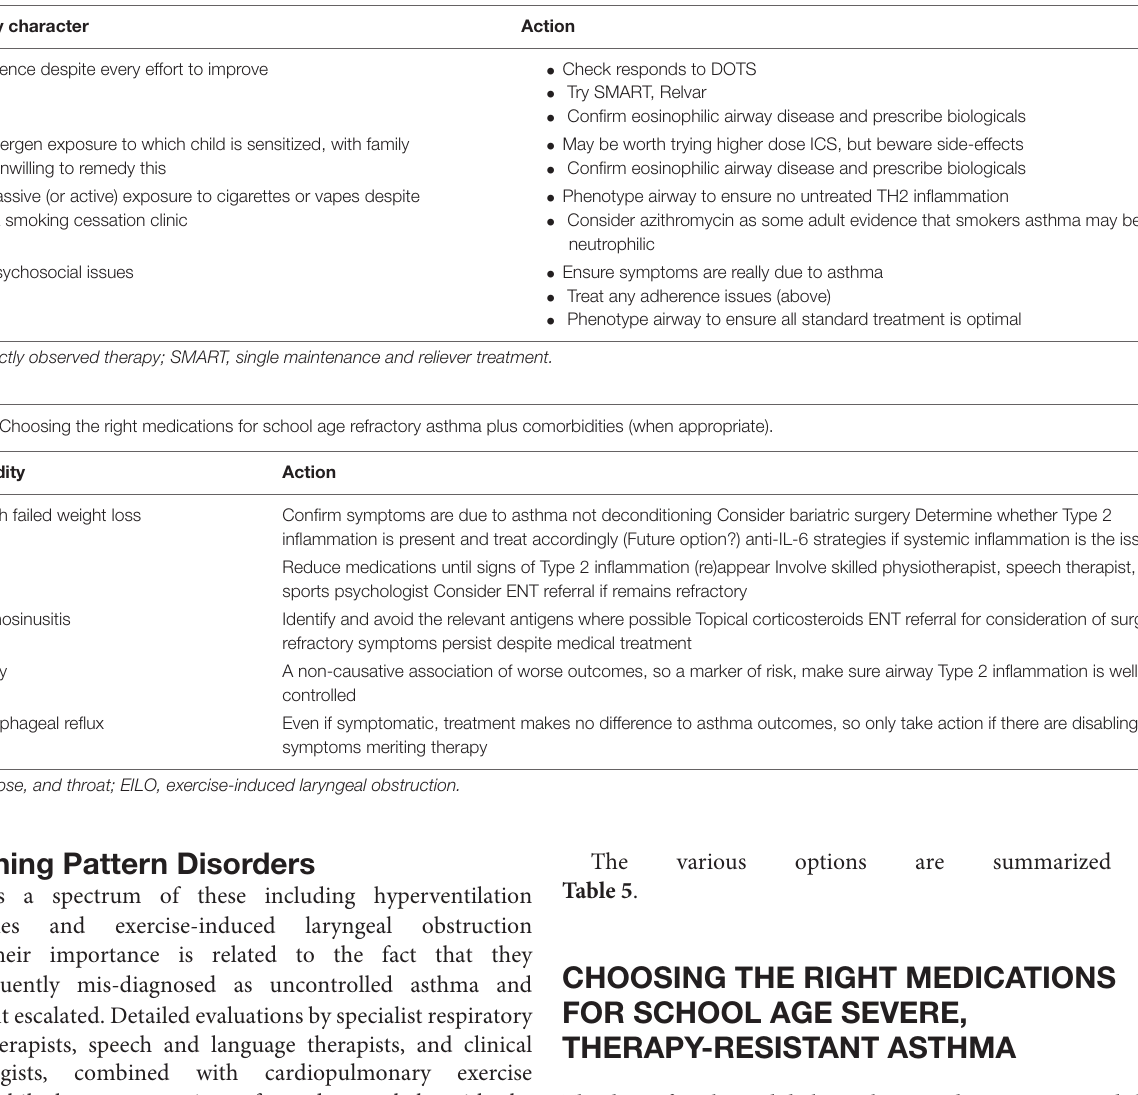
TABLE 4 | Choosing the right medications for school age refractory difficult asthma (when appropriate).